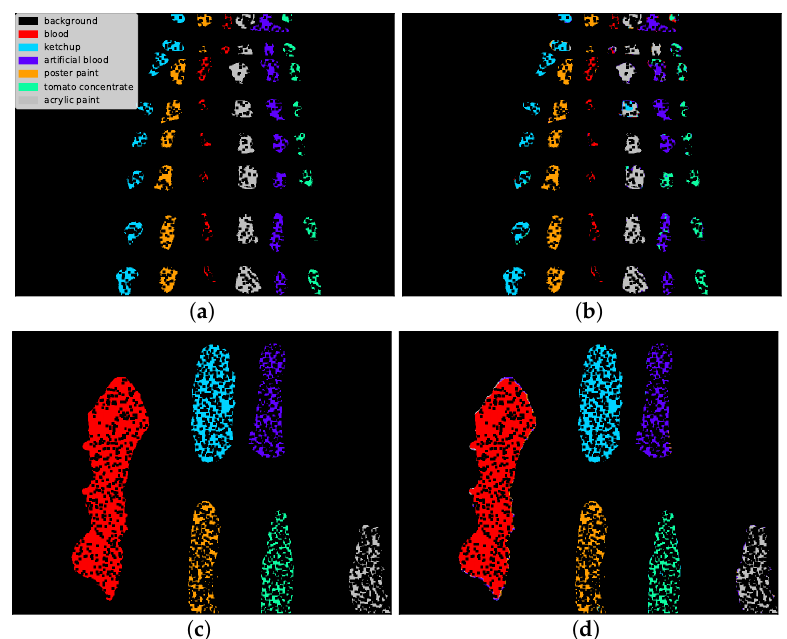
Figure 12. Two selected examples of classification maps for sample runs of the 1D CNN [10] and 2D CNN [24] architectures in the HTC scenario. Most of the classes were correctly labelled in this scenario, which resulted in high classification accuracy. ( a ) Ground truth for E(1) image. ( b ) Prediction of 1D CNN [10] network. ( c ) Ground truth for F(1) image. ( d ) Prediction of 2D CNN [24] network.